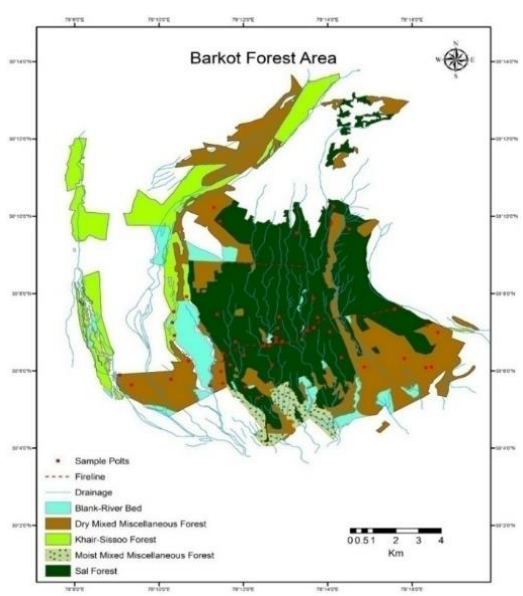
Figure 3: The field area consisting Sal forest, dry mixed miscellaneous forest, Khair-Sissoo forest and moist mixed miscellaneous forest. Most of the points lie in the Sal area since 57% area is covered by Sal forest Source: Chandola 2013 Table 2: Various forest types where Forty-nine sample plots are collected Forest type